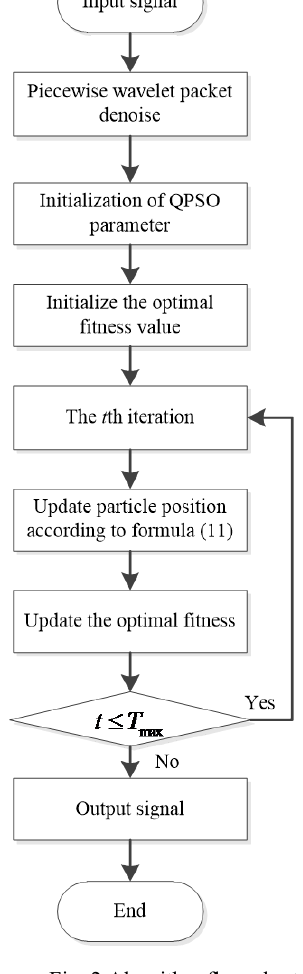
Fig. 2 Algorithm flow